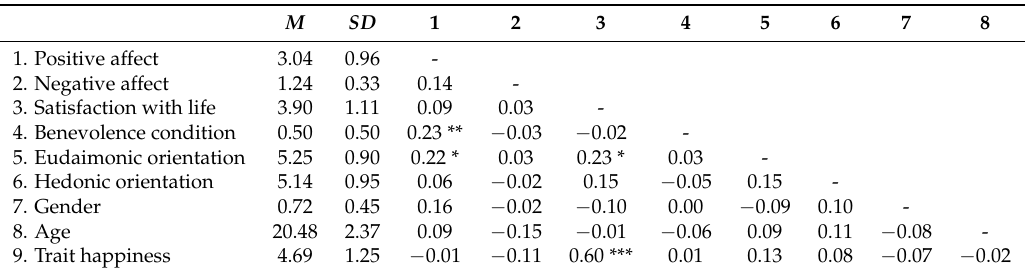
Table 1. Means, standard deviations, and zero-order correlations of the study variables across conditions. M SD 1 2 1. Positive affect